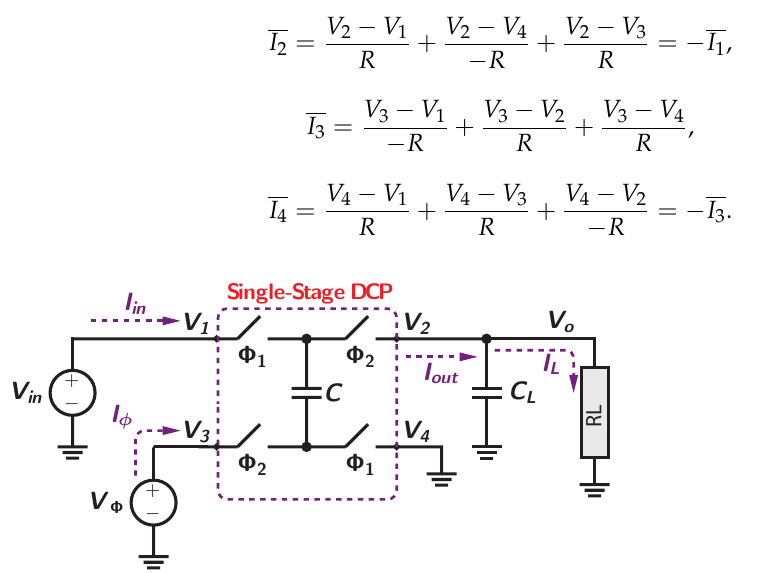
Figure 3. Circuit diagram of a single-stage DCP connected to a load.